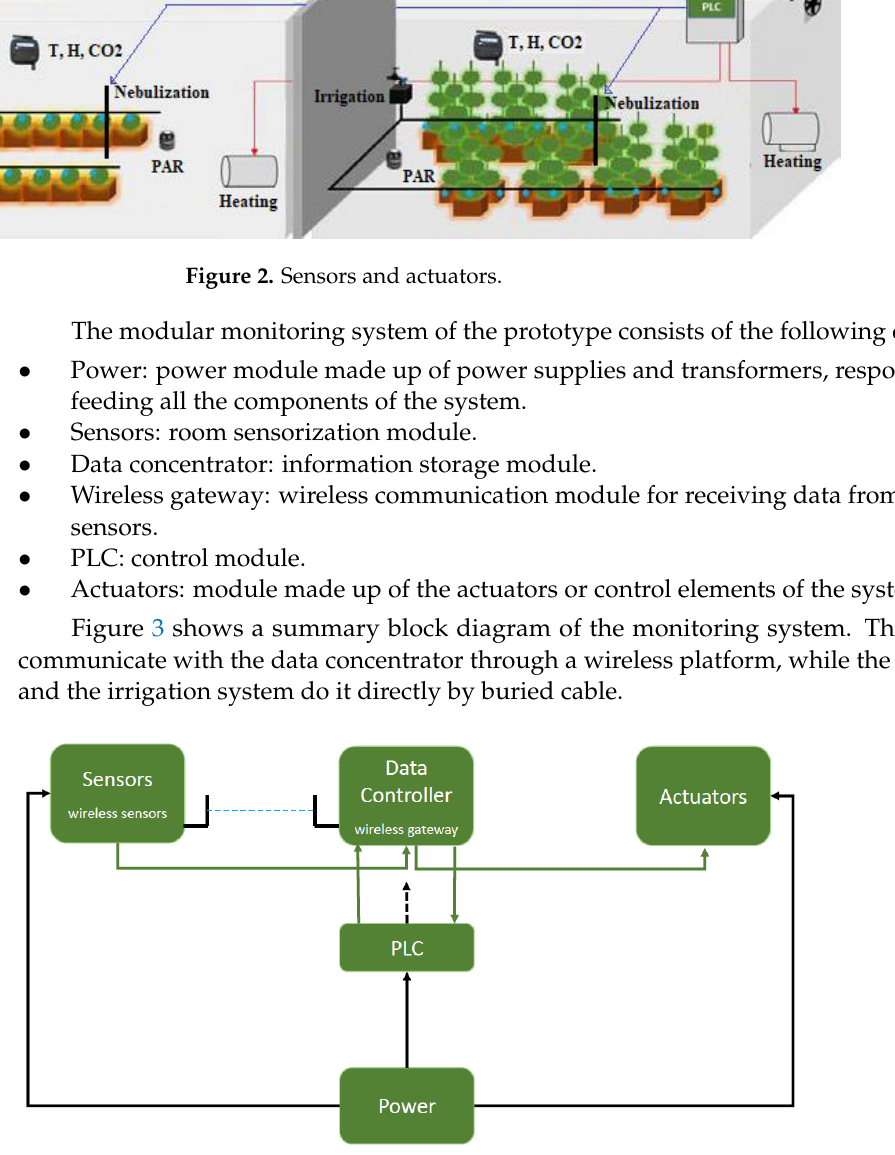
Figure 3. Block diagram of the general operation of the prototype.